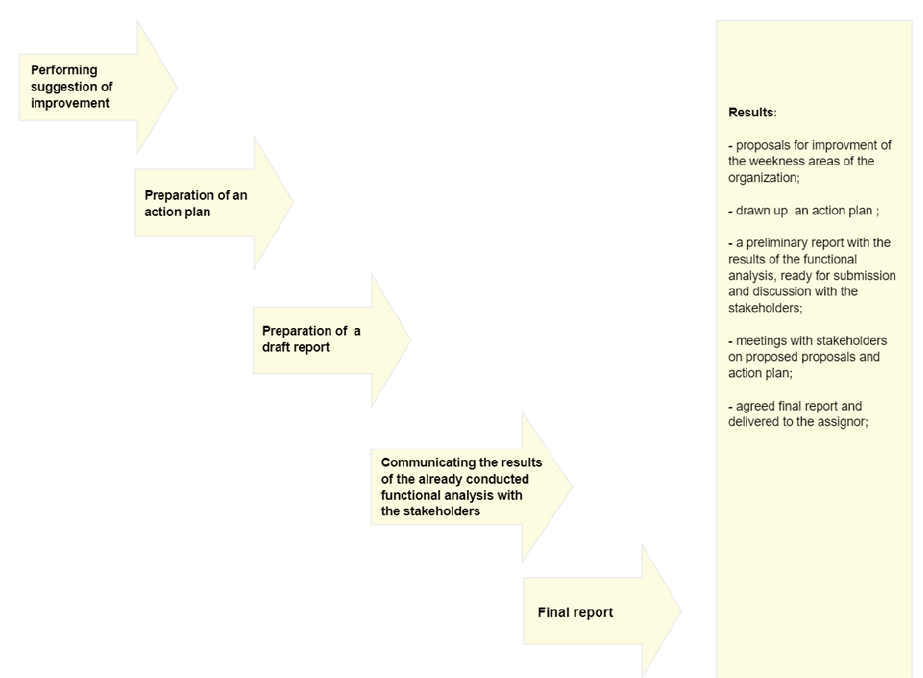
Figure 4: Stage 3